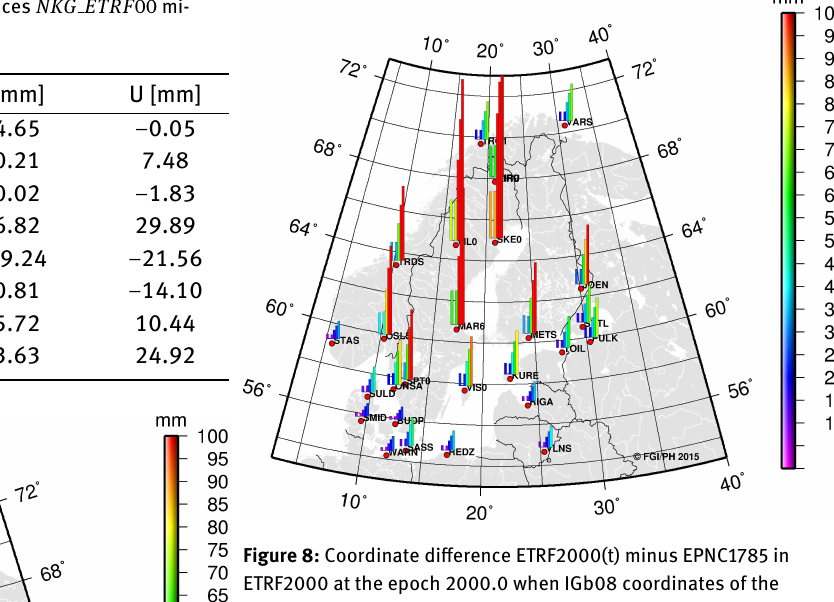
Figure 8: Coordinate difference ETRF2000(t) minus EPNC1785 in ETRF2000 at the epoch 2000.0 when IGb08 coordinates of the EPNC1785 are first converted with the station velocities to epochs 1990, 2000, 2010, 2020, 2030 and 2040 and then transformed with the standard EUREF transformation to the ETRF2000. Error bars from left to right show the difference for epochs